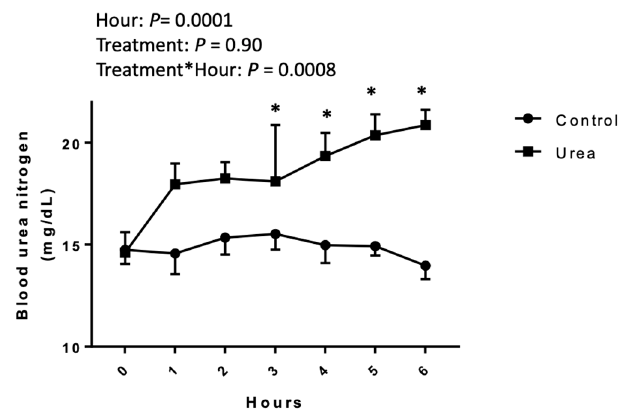
Figure 1. Blood urea nitrogen (mg/dL) analyzed in diestrus mares receiving an intravenous control or urea treatment over 6 hours in a crossover design. A fit least squares model was used, followed by a Student’s t-test. Results are presented as mean and SEM. The main effect of hour, treatment, and interaction are shown. * P ≤ 0.05.